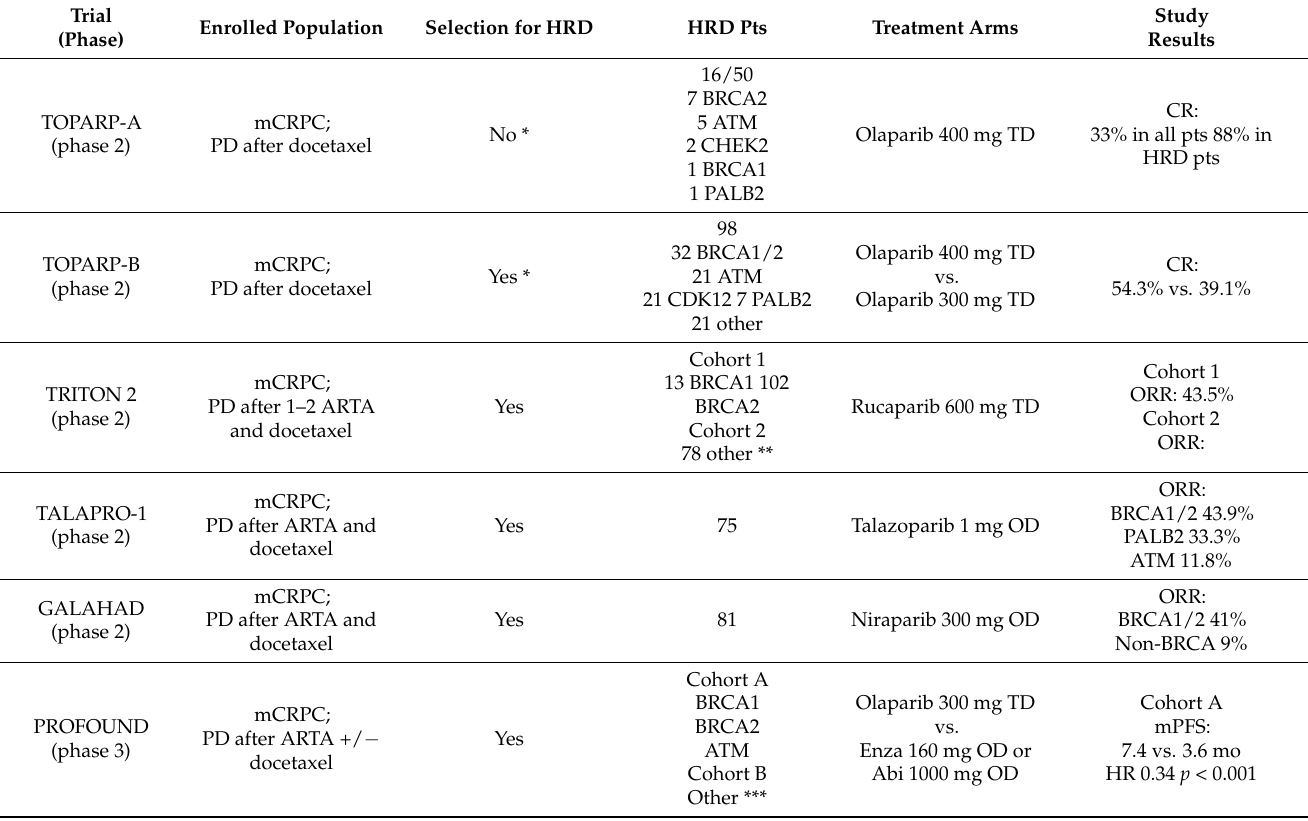
Table 3. Phase II–III trials of PARP inhibitor in monotherapy.